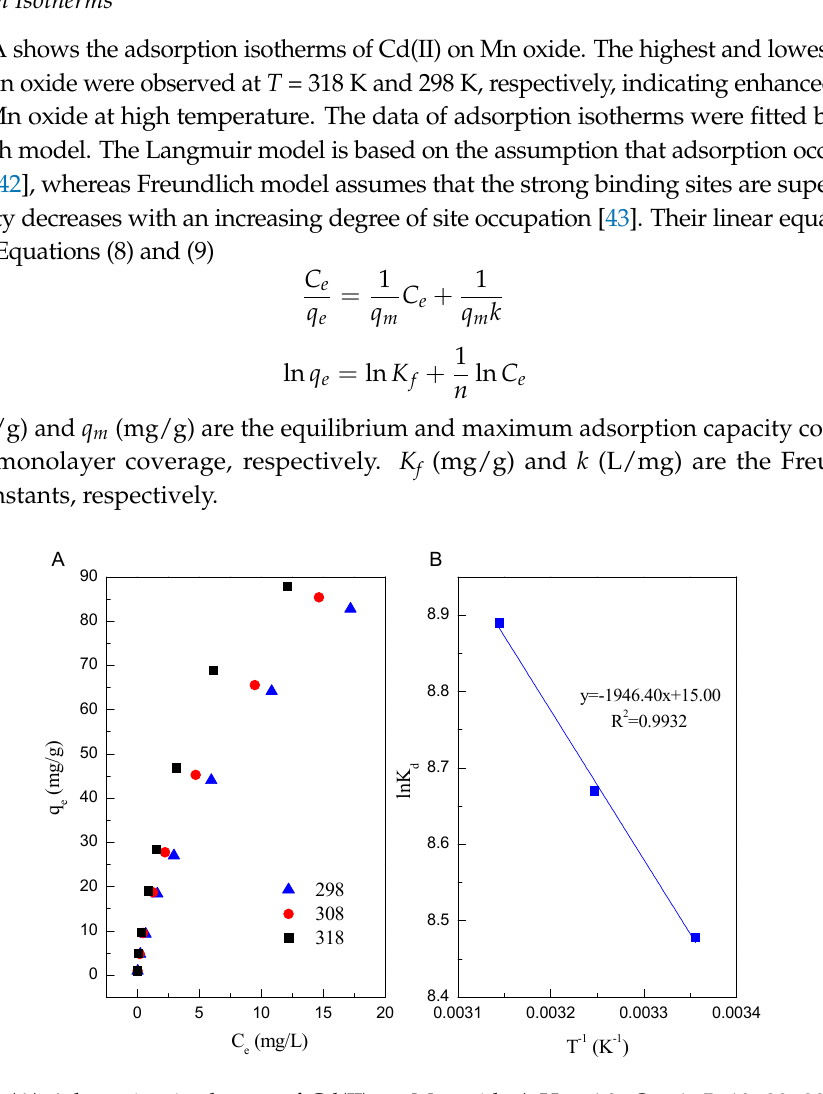
Figure 4. ( A ) Adsorption isotherms of Cd(II) on Mn oxide (pH = 6.0, C = 1, 5, 10, 20, 30, 50, 75, 100